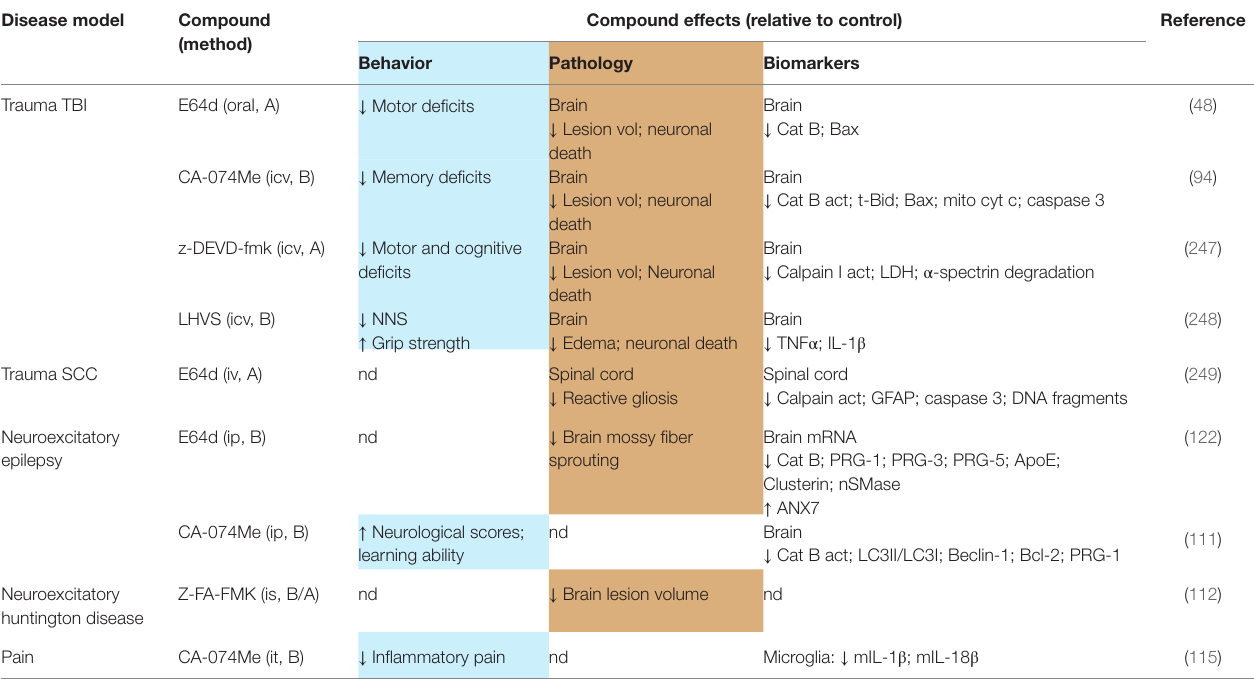
TABLe 6 | Small molecule inhibitors of cathepsin B are efficacious for improving behavioral and pathological deficits in TBi and TBi-related animal